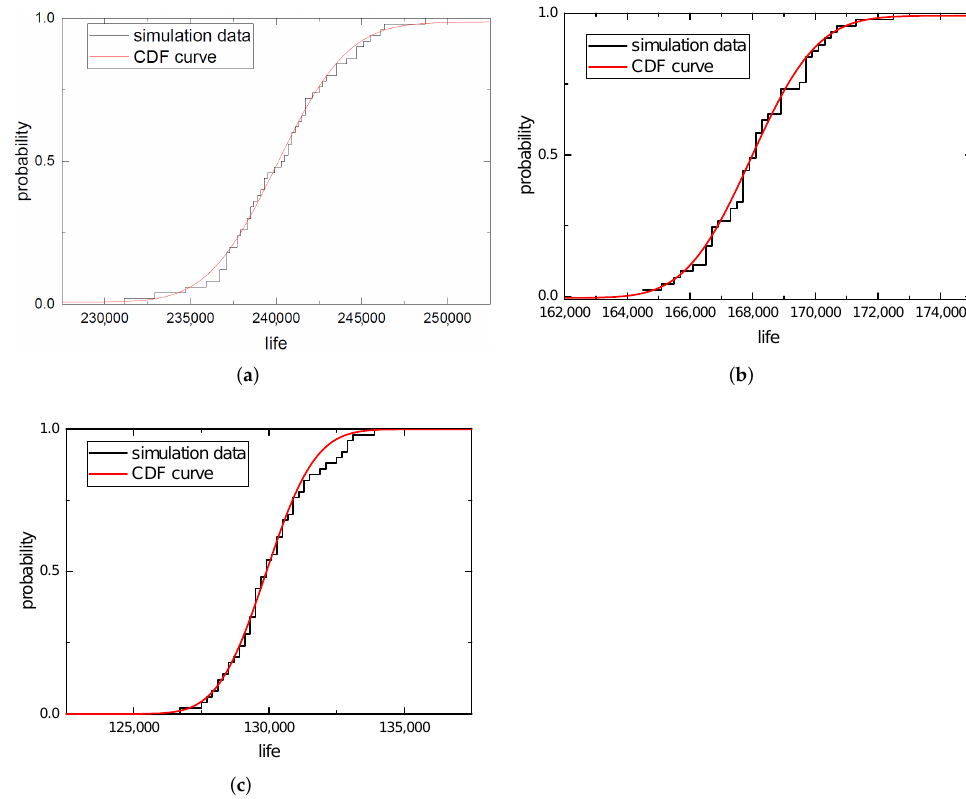
Figure 18. ( a ) Cumulative life span distribution curve of P max = 82 kN. ( b ) Cumulative life span distribution curve of P max = 90 kN. ( c ) Cumulative life span distribution curve of P max = 98